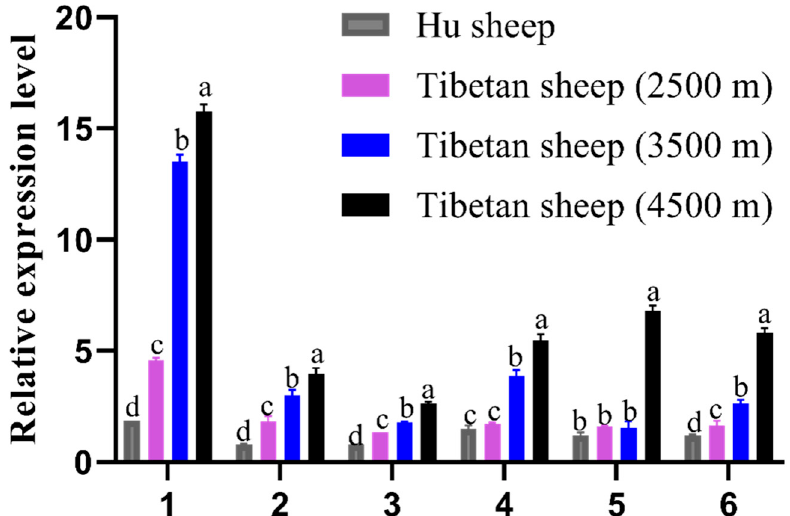
Figure 2. Relative expression levels of EPAS1 mRNA in different tissues of Hu sheep and Tibetan sheep from different altitudes. Heart (1), liver (2), spleen (3), lung (4), kidney (5), and longissimus dorsi muscle (6) tissue were analyzed for mRNA expression. The bars represent the mean ± SE from three independent biological replicates, each performed with three technical replicates. The different letters indicate significant differences ( p < 0.05); the same letter indicates no significant differences ( p > 0.05).